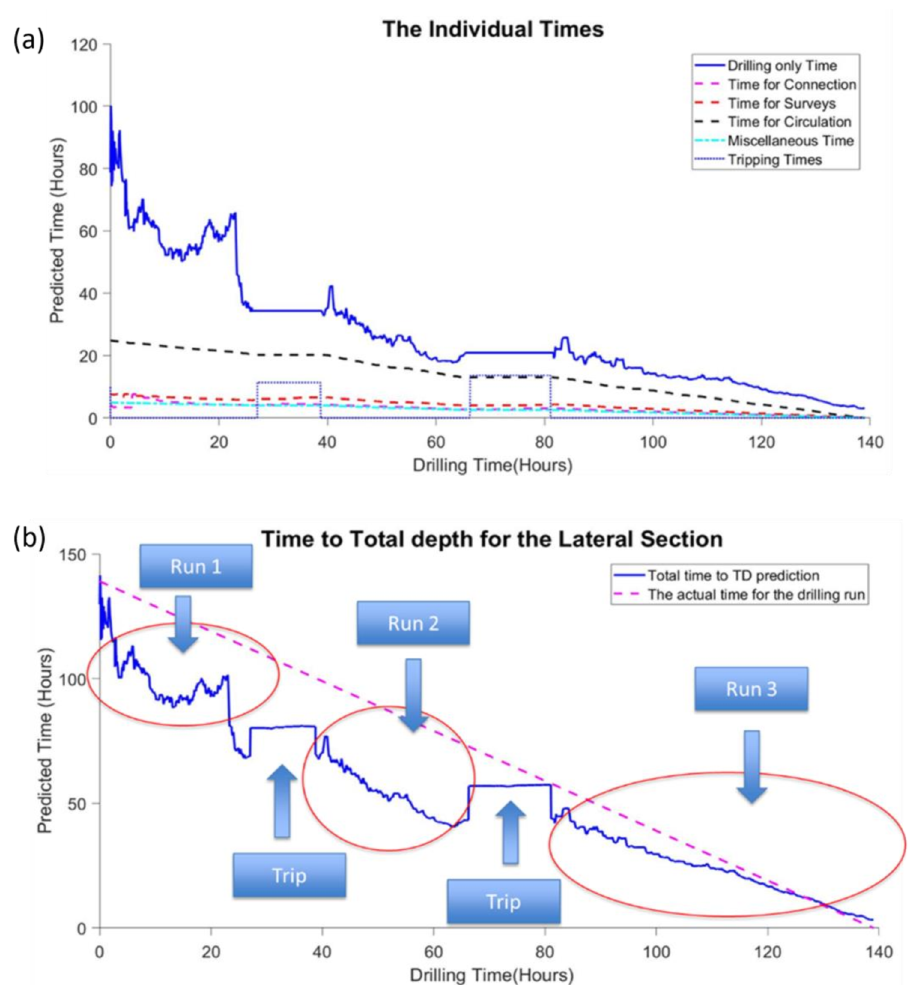
Figure 11. ( a ) Estimated individual times for different rig states versus time; ( b ) total time to TD predictions versus time.